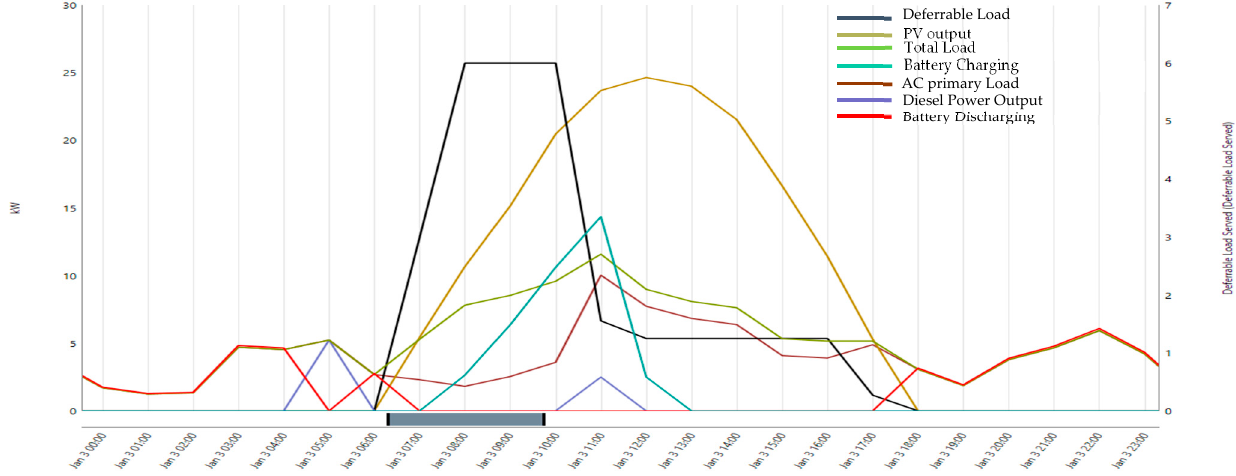
Figure 12. Daily time series analysis for winter season.